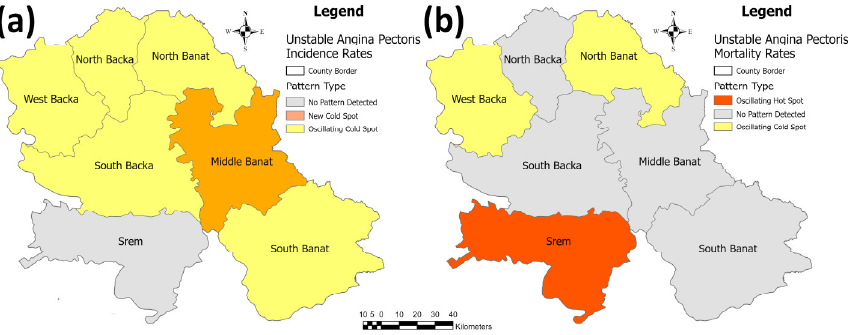
Figure 13. Identified patterns in the emerging hot spot analysis for the unstable angina pectoris incidence/mortality rates per 100,000 population in the province: ( a ) incidence rates, and ( b ) mortality rates.